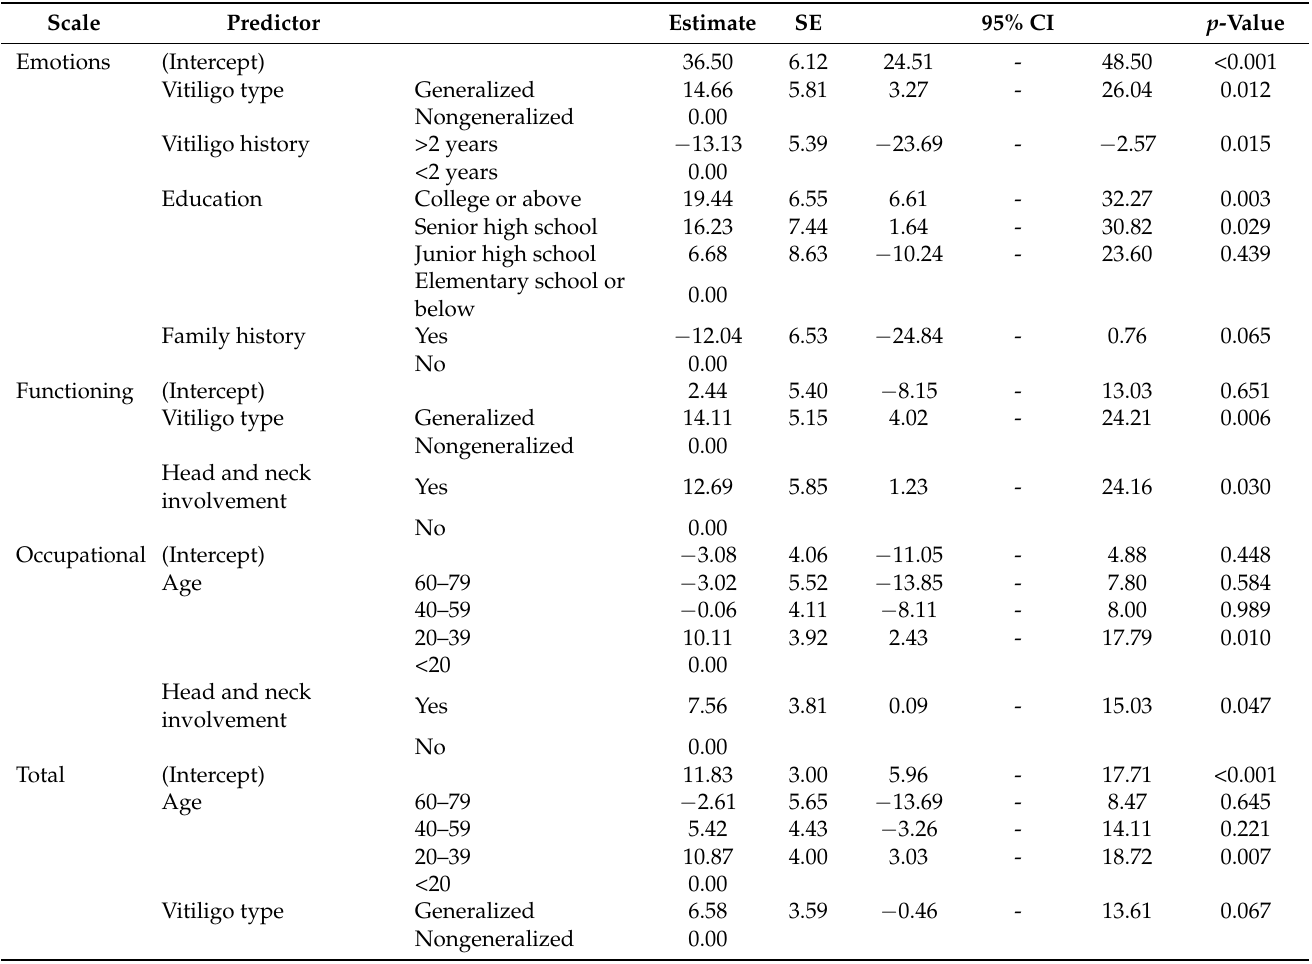
Table 5. Results of generalized linear model on each scale in patients with